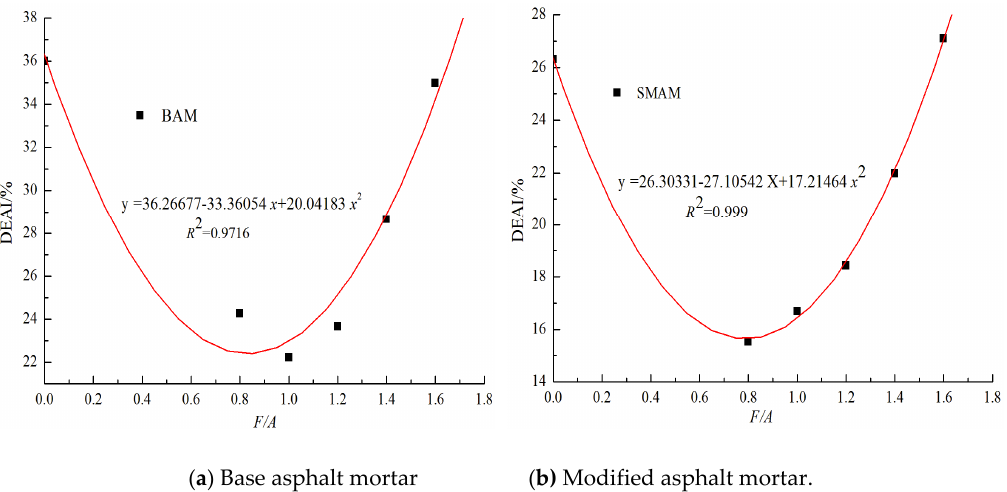
Figure 6. The DEAI value of asphalt mortar.